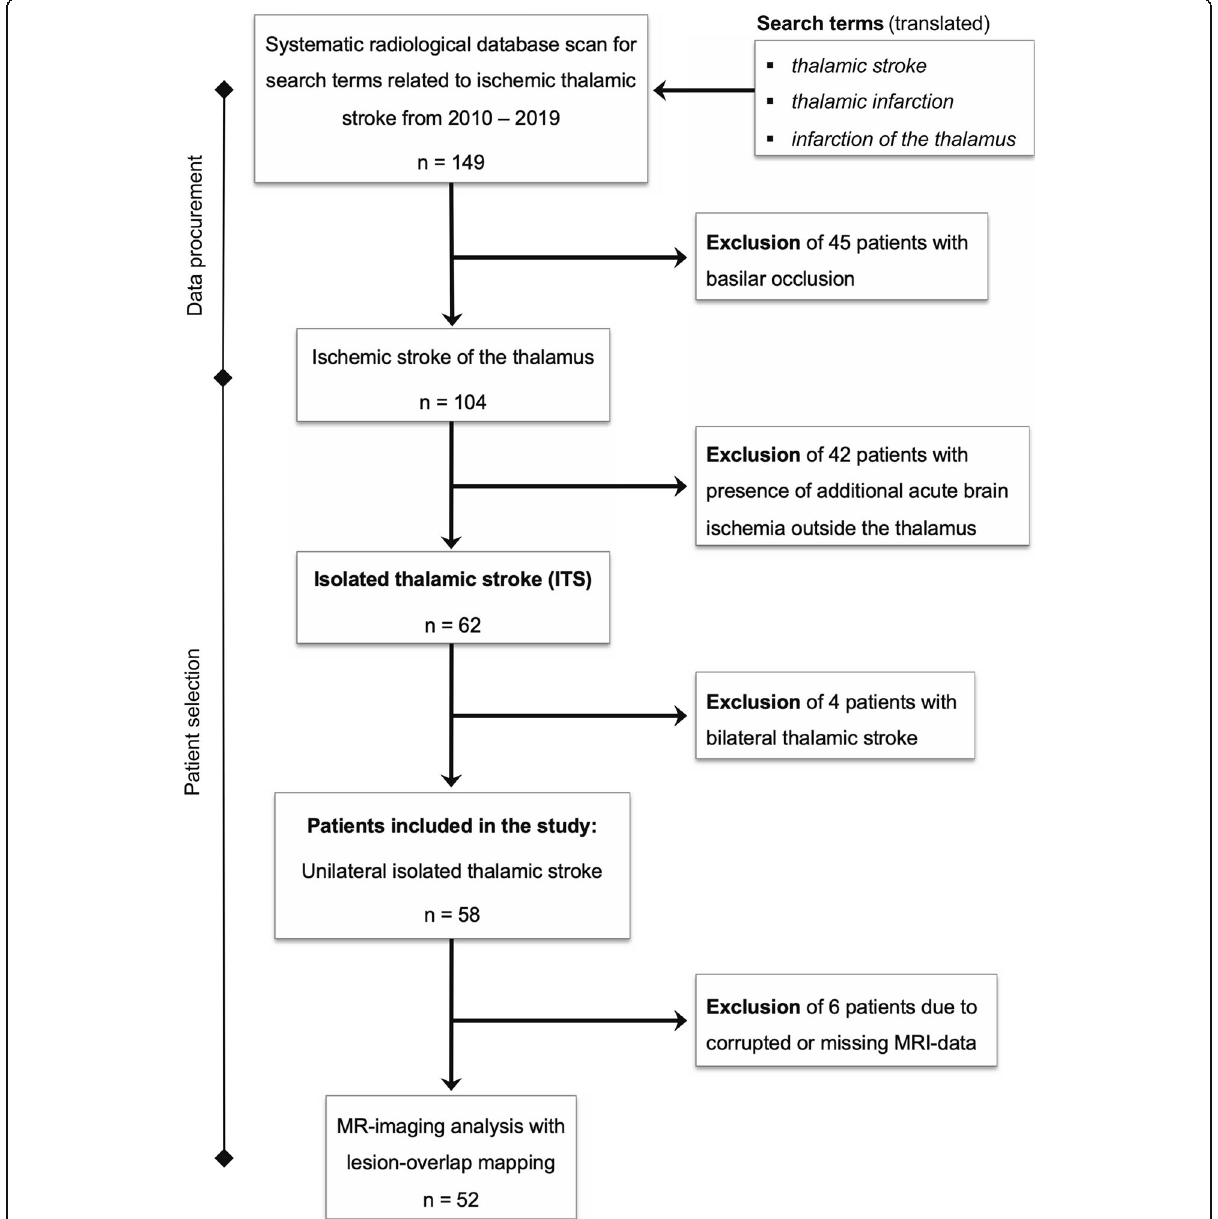
Fig. 1 Study flowchart describing the data procurement and stepwise patient selection process intended for retrospective